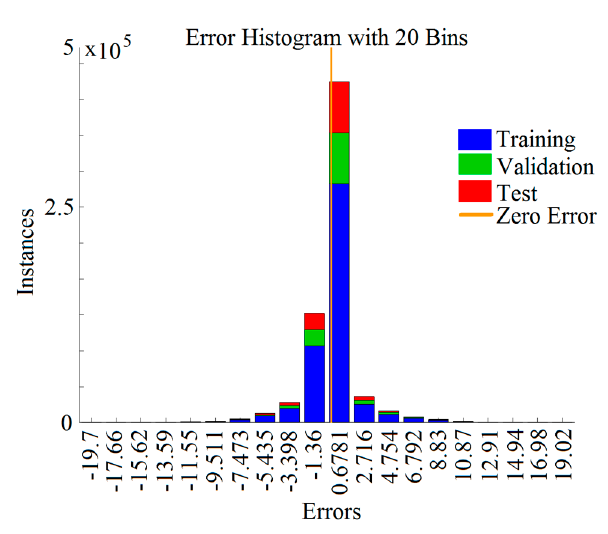
Figure 7. TDNN performance.